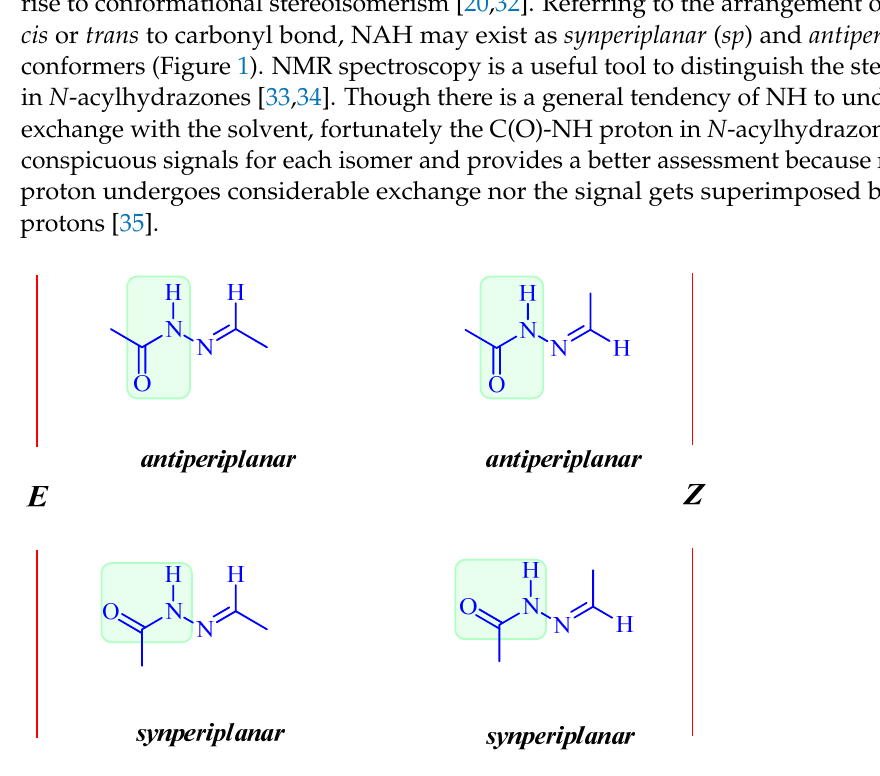
Figure 1. Stereoisomers of N -Acylhydrazones.